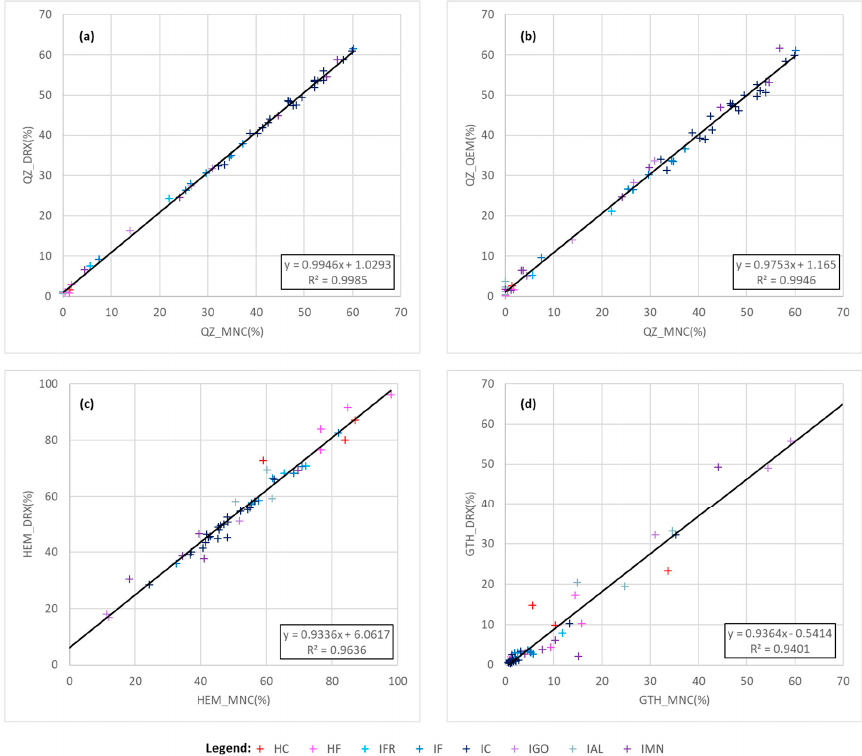
Figure 5. Scatter diagrams mineral proportions of quartz ( a , b ), hematite ( c ) and goethite ( d ) calculated by MNC-weathered and XRD/Rietveld (left side) or QEMSCAN (right side) methods using weathered samples.